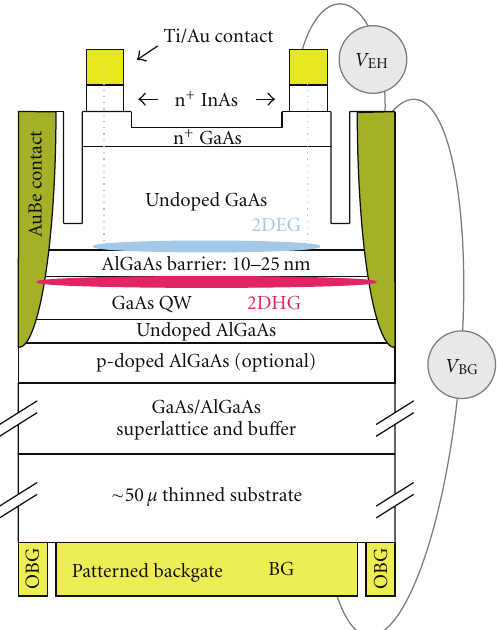
Figure 3: The schematic representation of the EHBL developed in the authors’ group. Note that two voltage biases are in general needed for operating the device. However, the outer backgate below the ohmic contacts ( V obg ) to the holes is often biased di ff erently from the backgate in the central region ( V bg